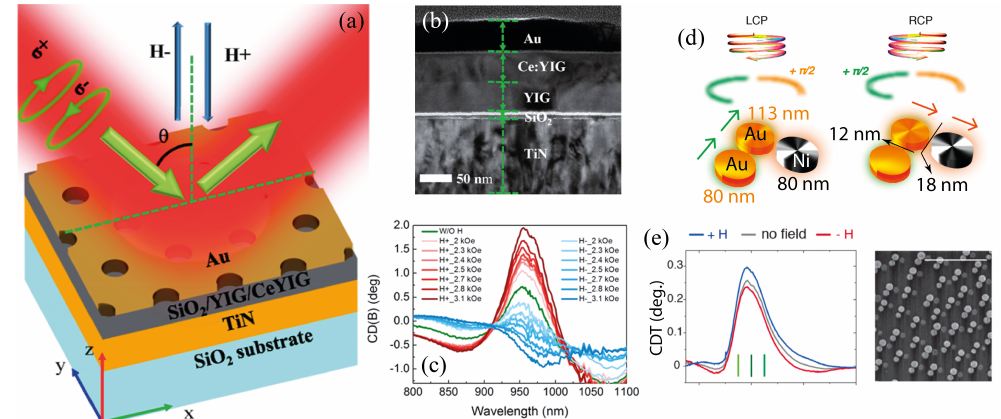
Figure 5. ( a ) Schematic of the magnetoplasmonic multilayer nanostructure for switching the extrinsic optical chirality by using the magneto-chiroptical effect. The applied magnetic field can be alternated between the + z (H+) and − z (H − ) directions, as indicated, and the incident CPL can be RCP ( σ + ) or LCP ( σ − ). ( b ) Different material layer thicknesses are highlighted by using a cross-sectional TEM micrograph. ( c ) Results of magneto-chiroptical effect are comparatively shown with the extrinsic chiroptical activity (without W/O H, see the green line) through CD measurements, for an angle of incidence θ = 45 ◦ , by using magnetic field amplitudes varying from − 3.1 kOe to + 3.1 kOe (applied along the z axis, as illustrated). Reprinted with permission from Qin et al., ACS Nano 14 , 2808 (2020) [31]. Copyright 2020 American Chemical Society. ( d ) Magnetoplasmonic chiral arrange of Au and Ni nanoantennas on a substrate. Green and orange arrows are used to indicate longitudinal resonances of bimetallic nanoparticles, excited with quarter-period phase delay. ( e ) Experimental results for the CDT associated to H+ and H- are comparatively shown with the case without